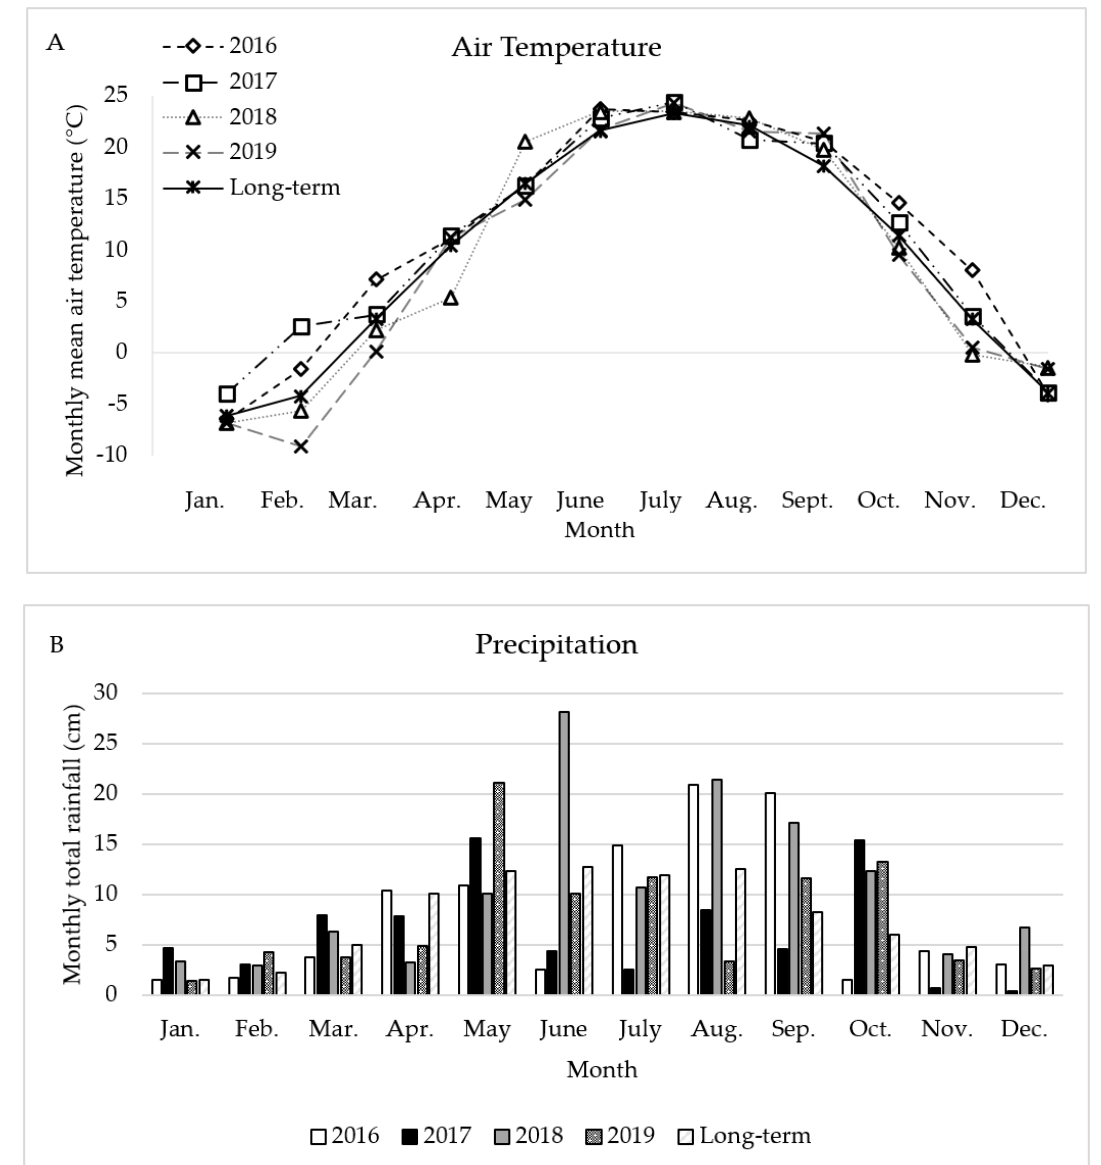
Figure 1. ( A ) Monthly mean air temperature for 2016, 2017, 2018, 2019, and long-term average for Ames, IA, USA, and ( B ) total precipitation for 2016, 2017, 2018, 2019, and long-term average for Ames, IA, USA.